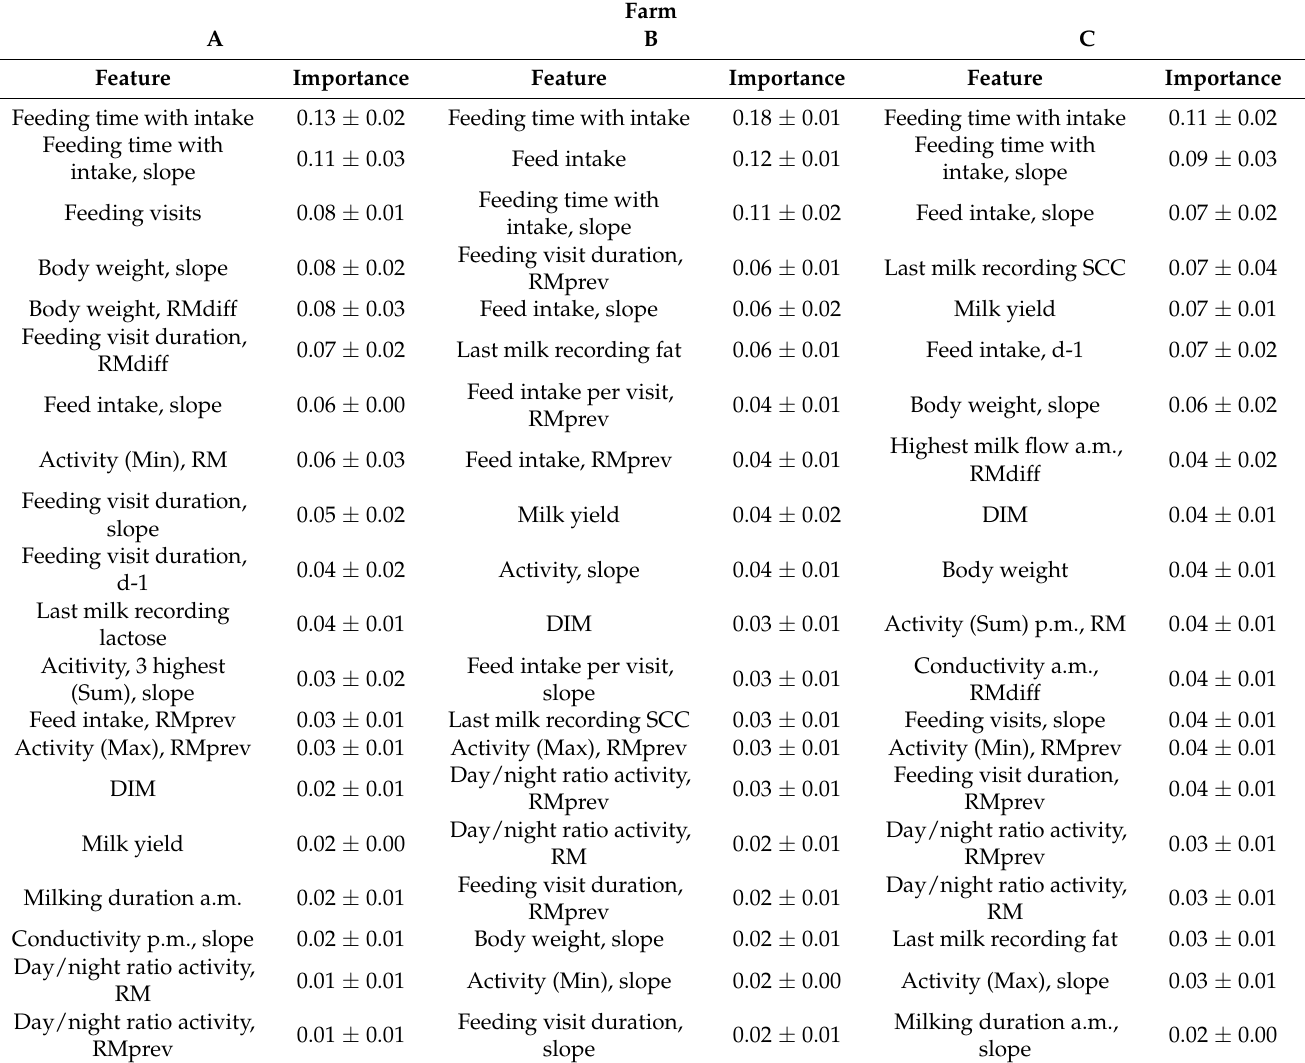
Table A2. Random Forest feature importance for lameness treatments (Mean ± 95% CI), obtained during 5-fold cross